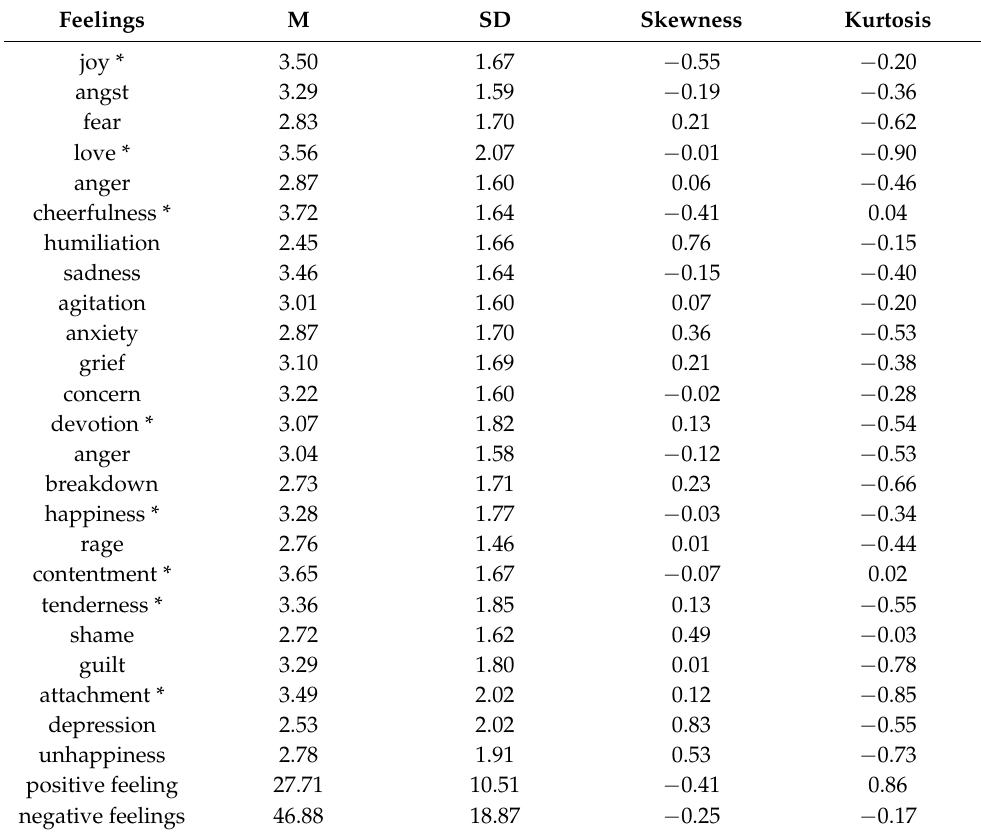
Table 6. Descriptive statistics for the Emotions Questionnaire (N = 250) for inmates. Feelings M SD Skewness